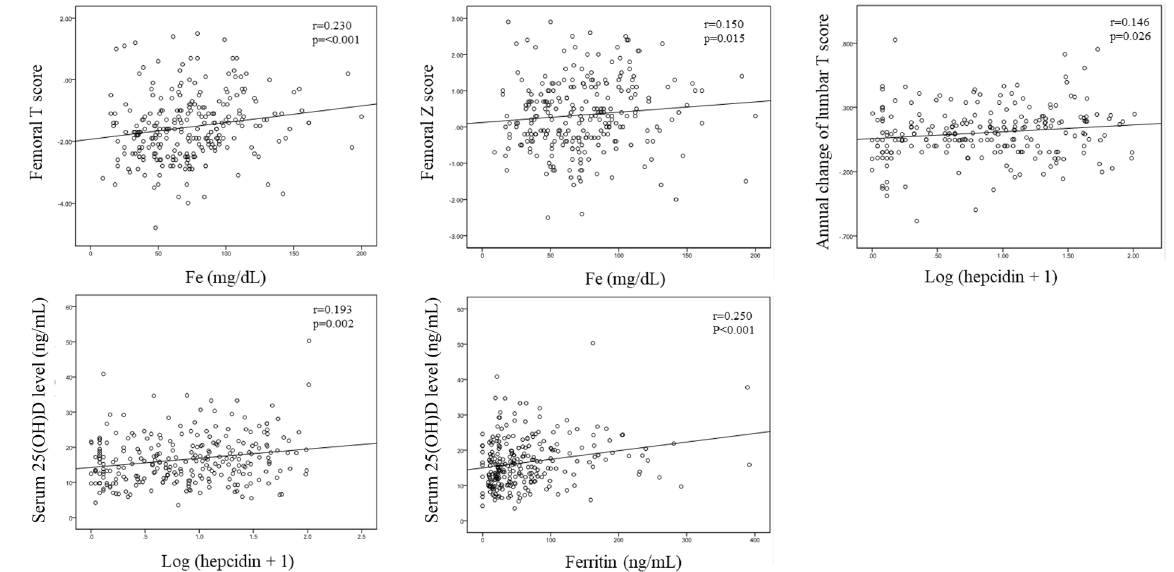
Figure 2. Scatter plots of iron metabolism and osteoporosis markers.